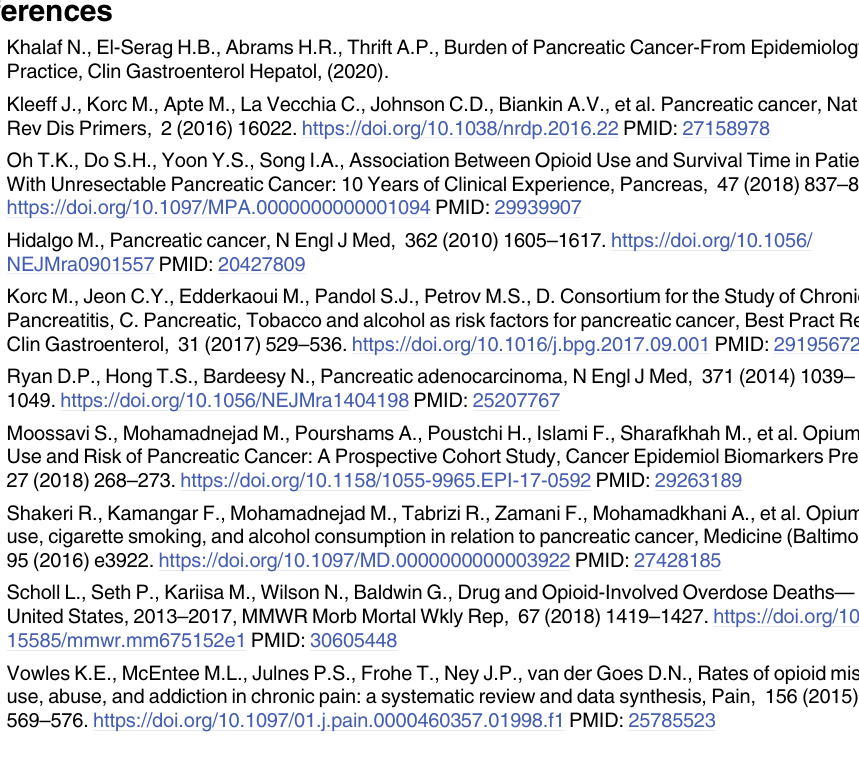
S2 Fig. (A) National prevalence of obesity through the years 1999 to 2018, (B) National preva- lence (%) of alcohol use through the years 1999 to 2018, (C) National prevalence (%) of tobacco use through the years 1999 to 2017. (TIF) S3 Fig. (A) State prevalence of obesity overtime, Prevalence of obesity by state through the years 1999 to 2018, (B) Prevalence of alcohol use by state through the years 1999 to 2018, (C) Prevalence of tobacco use by state through the years 1999 to 2017.